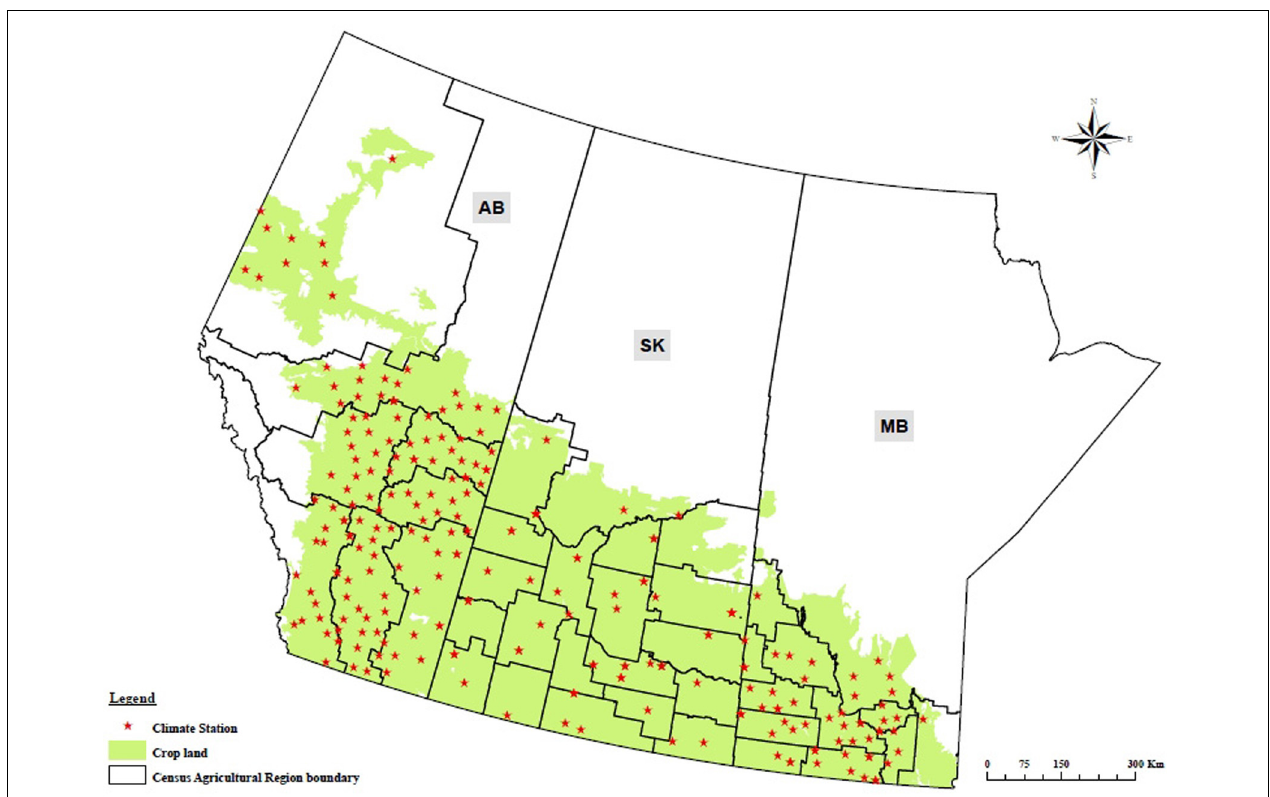
FIGURE 1 | The major region of wheat production of the Canadian Prairies, encompassing the provinces of Alberta (AB), Saskatchewan (SK), and Manitoba